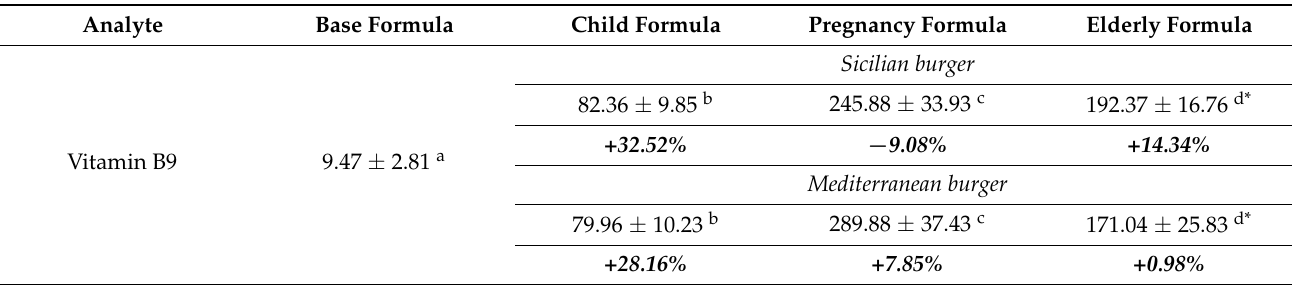
Table 5. Vitamin B9 ( µ g/100 g, fw) detected control and Sicilian and Mediterranean chicken burgers. The variation (%) from the expected fortification amounts are reported in bold and italic. Data are reported in terms of mean ± standard deviation of n = 10 samples for control and of n = 5 samples for each treatment/recipe combination, where each sample was analyzed three